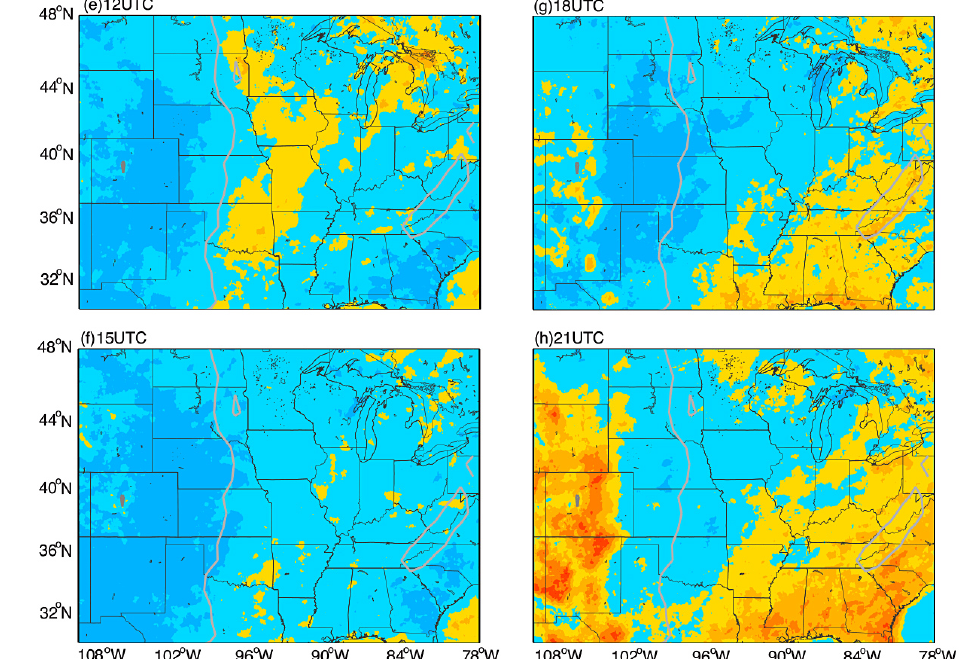
Figure 4b. Similar to Fig. 4a but from 12:00 to 21:00UTC (e–h) .